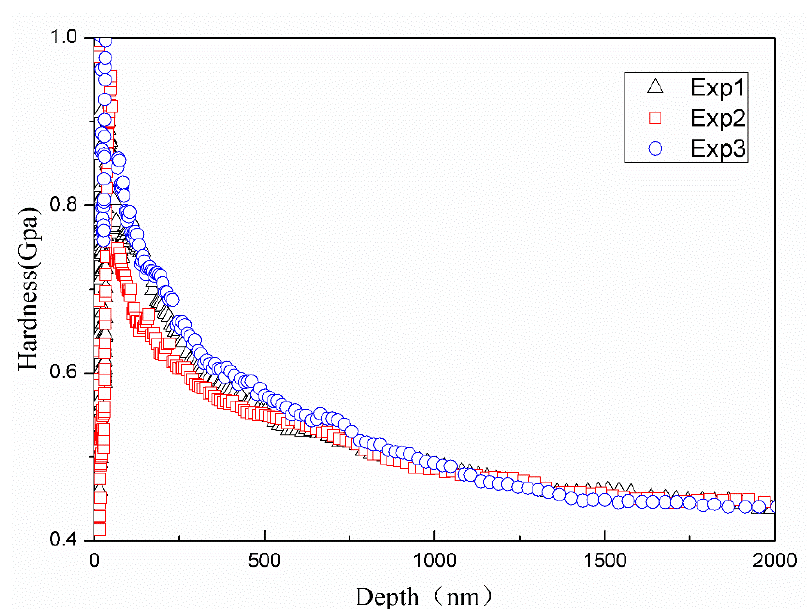
Figure 4. Nanoindentation hardness - depth curves of 45° from three repeated experiments.